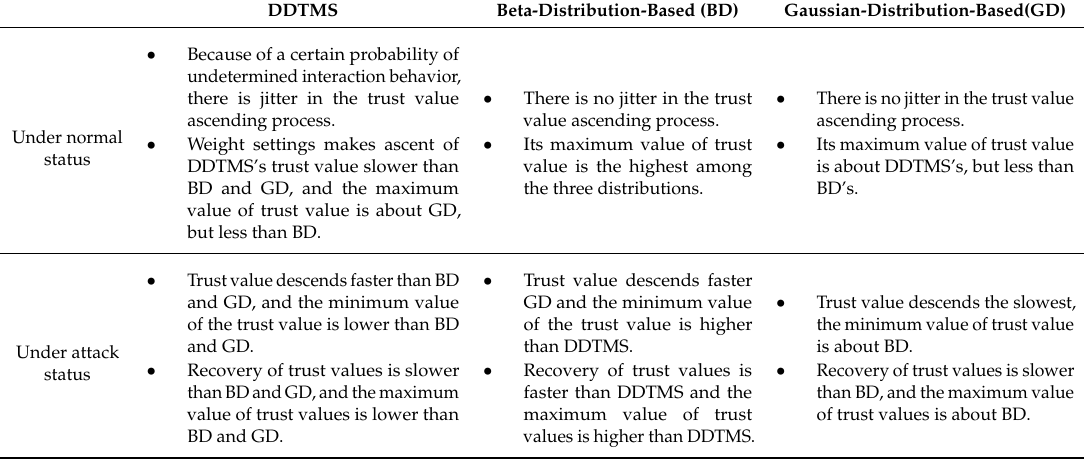
Table 2. Comparison between DDTMS, Beta-distribution-based, and Gaussian-distribution-based. DDTMS Beta-Distribution-Based (BD) Gaussian-Distribution-Based(GD)